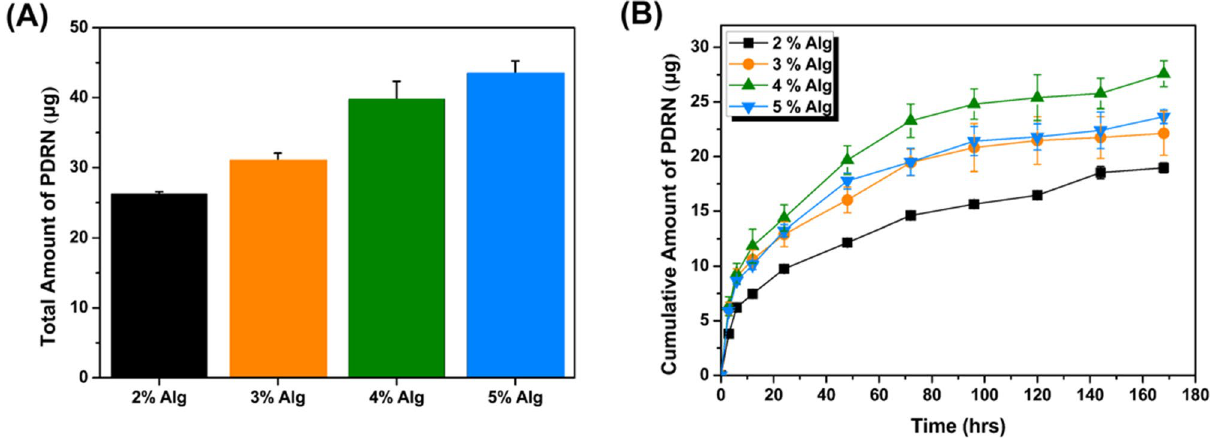
Figure 3. ( A ) Total amount of PDRN remaining inside the Alg-PDRN hydrogel carrier after surface extraction and ( B ) PDRN releasing profile of the Alg-PDRN hydrogels with different Alg